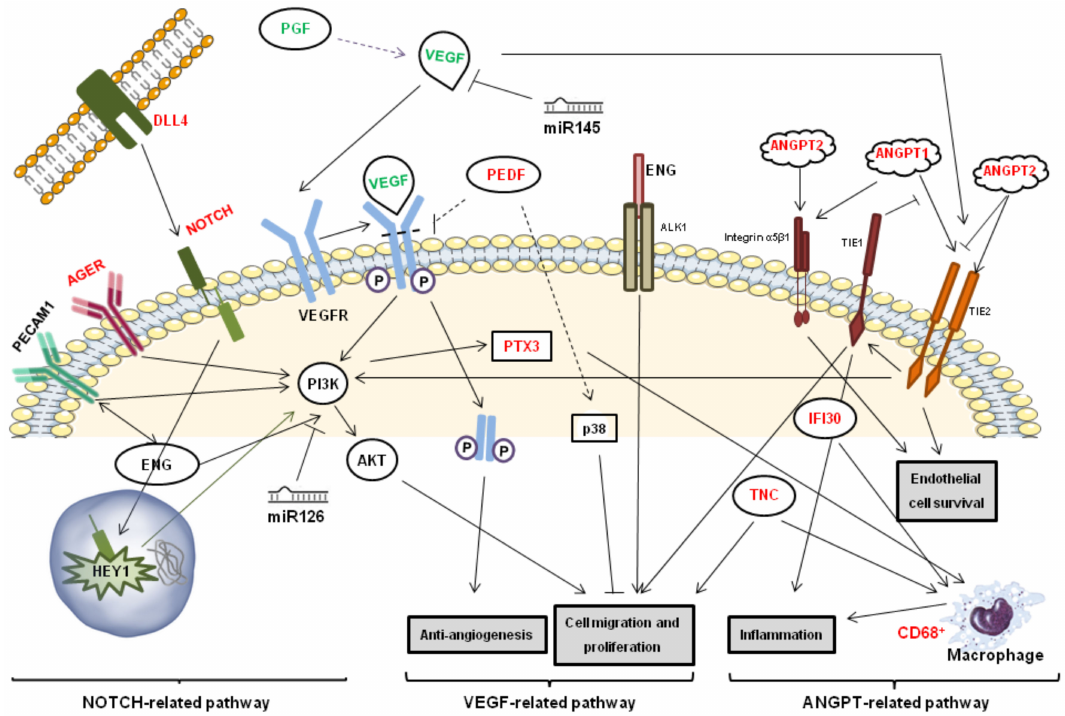
Figure 9. Inflammatory and angiogenic pathways di ff erentially a ff ected in SAT versus VAT, in green downregulated and red up